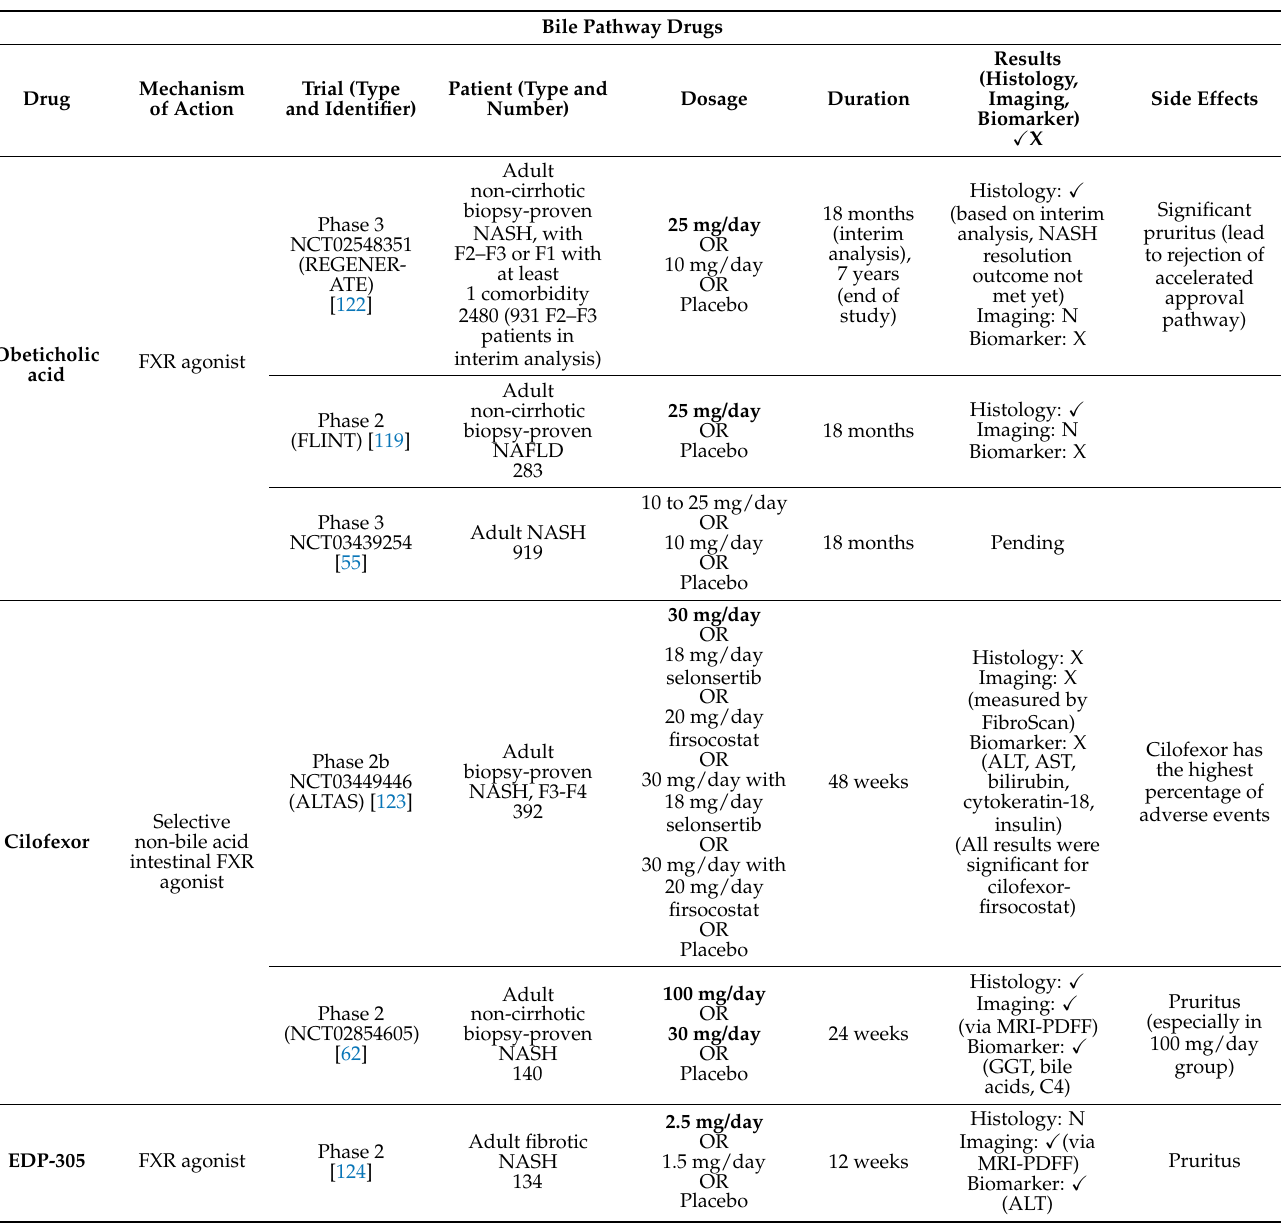
Table 7. Clinical trials on bile pathway drugs